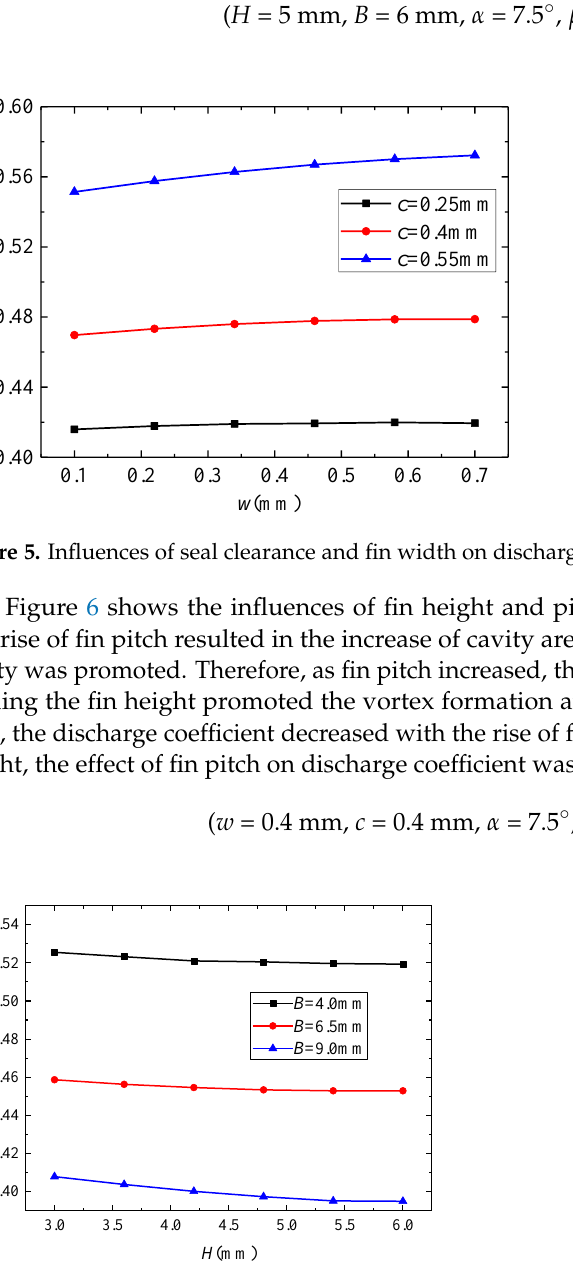
Figure 6. Influences of fin height and pitch on discharge coefficient. ( w = 0.4 mm, c = 0.4 mm, α = 7.5°, β = 7.5°)